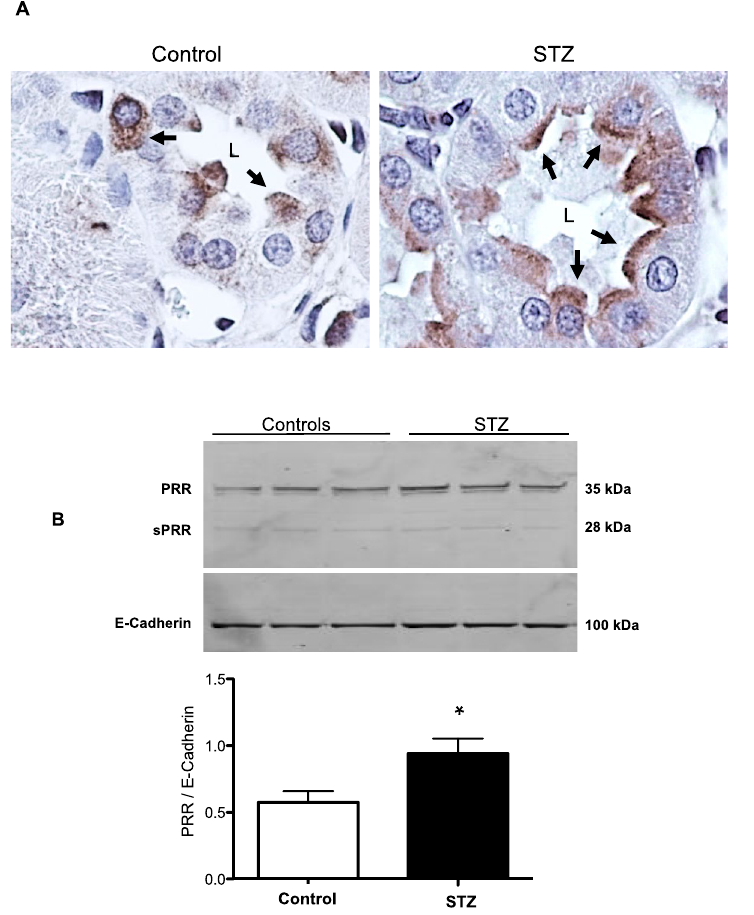
Figure 6. PRR is translocated to the cell plasma membrane in collecting ducts of STZ rats. ( A ) Representative image of PRR immunohistochemistry in medullary kidney slides of control and STZ diabetic rats. As observed, PRR is mostly observed on the apical side of the collecting duct cells (arrows) in STZ rats, while in control rats PRR is present more diffusely in the cytoplasm. ( B ) Representative immunoblots (n = 3) showing the increase of PRR abundance in the plasma membrane fractions in medullary tissues of STZ rats. E-cadherin was used as a constitutive protein for plasma membrane fractions. *P < 0.05 versus control rats.